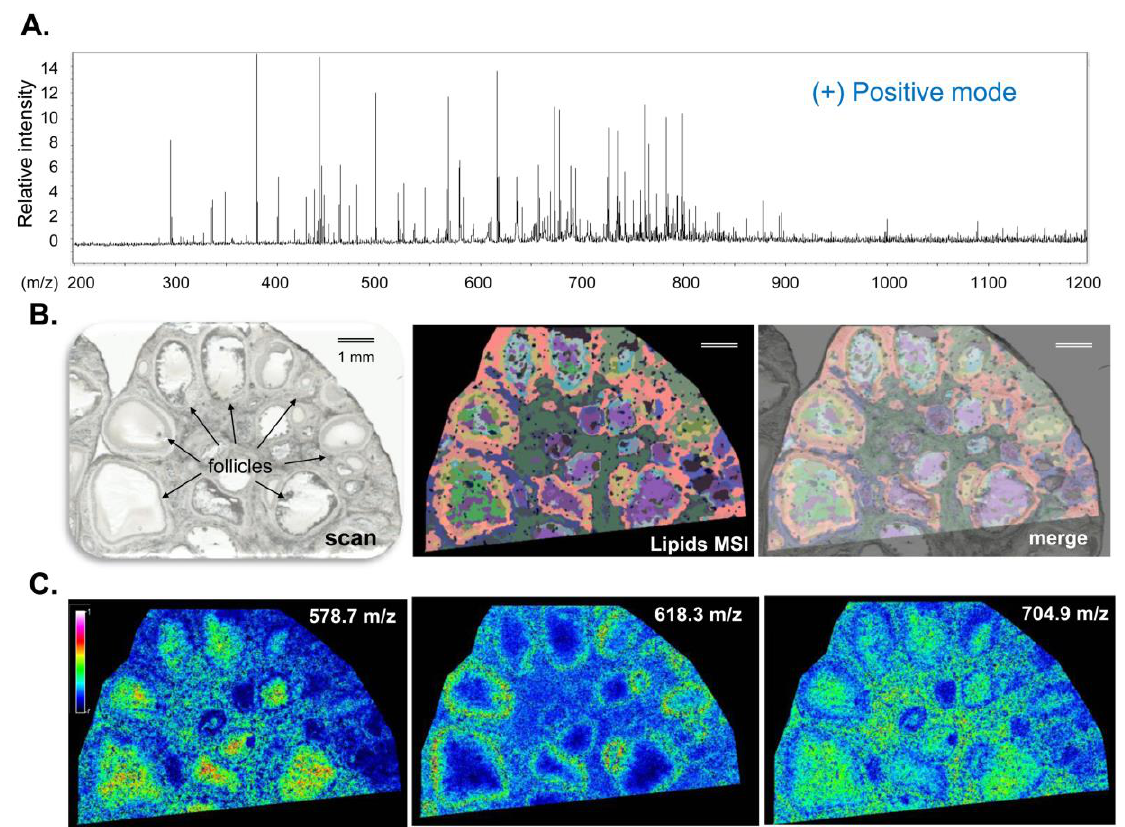
Figure 2. High-resolution MALDI MSI in positive reflector ion mode. MALDI MSI analysis of porcine ovary section acquired at 22 µm spatial resolution. ( A ) Skyline projection spectrum of molecular species (lipids) in the m/z 200–1200 range; ( B ) Histological image of ovary section (digital scan at 7200 dpi) overlaid (merge) on molecular reconstruction image (Lipids MSI); ( C ) Molecular images of three lipids showing preferential localization to follicular fluid (m/z 578.7), to follicular wall cells (m/z 618.3) and to interstitial tissue outside follicular cells (m/z